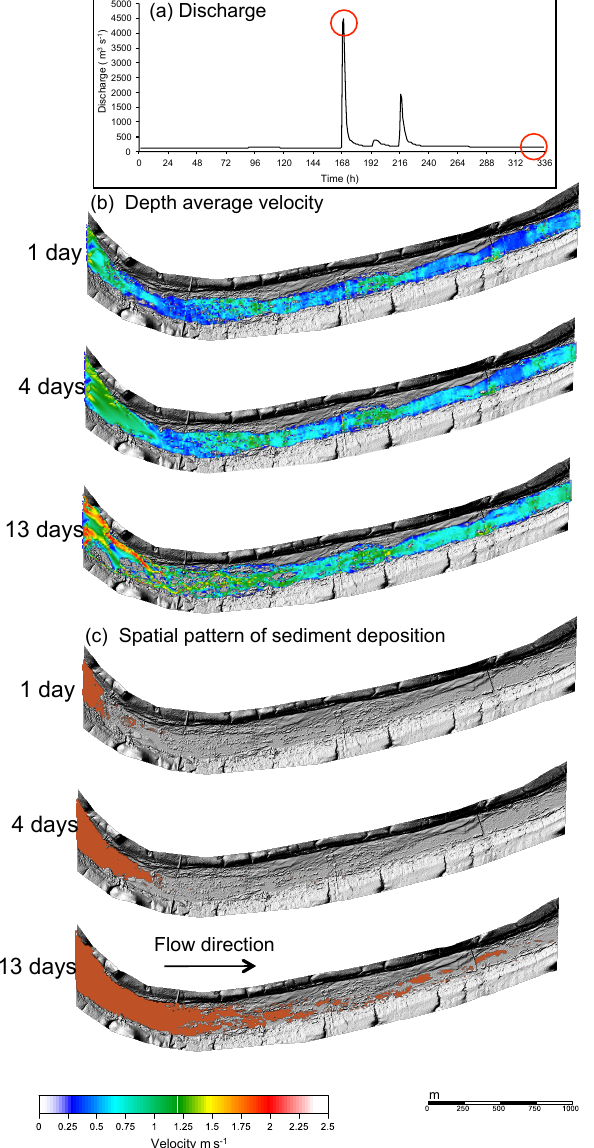
Figure 2. CAESAR-Lisflood simulations: (a) Discharge time- series with 4500 and 200m 3 s − 1 flows highlighted; (b) depth- averaged velocity patterns, (c) spatial patterns of deposition as a sediment slug (orange shading) is dispersed through the model do- main.